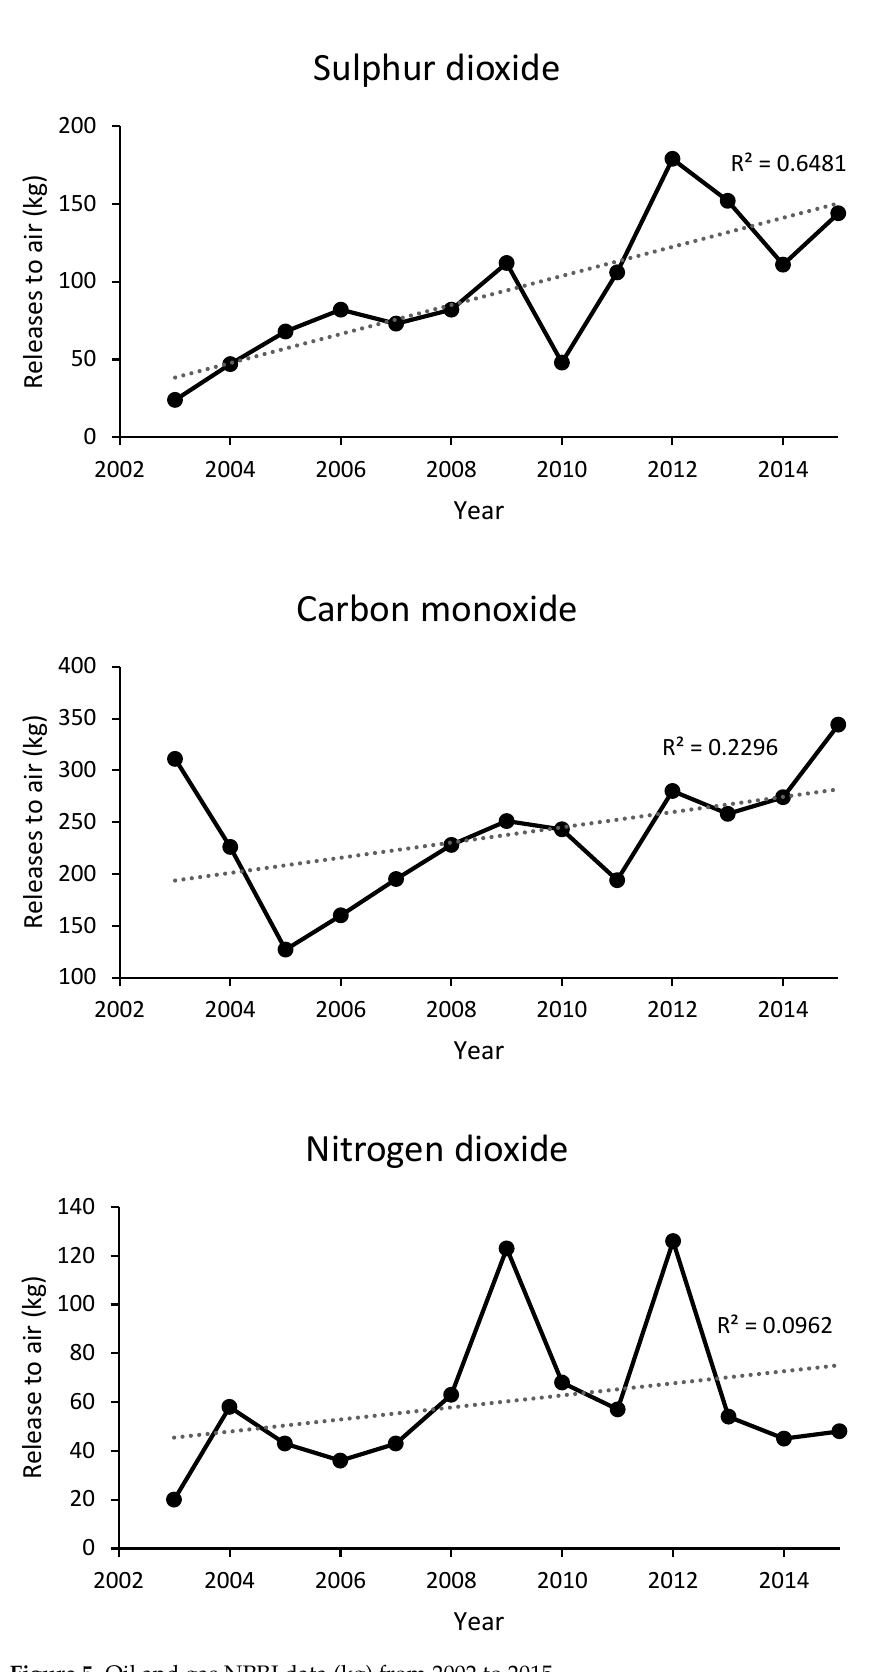
Figure 5. Oil and gas NPRI data (kg) from 2002 to 2015.